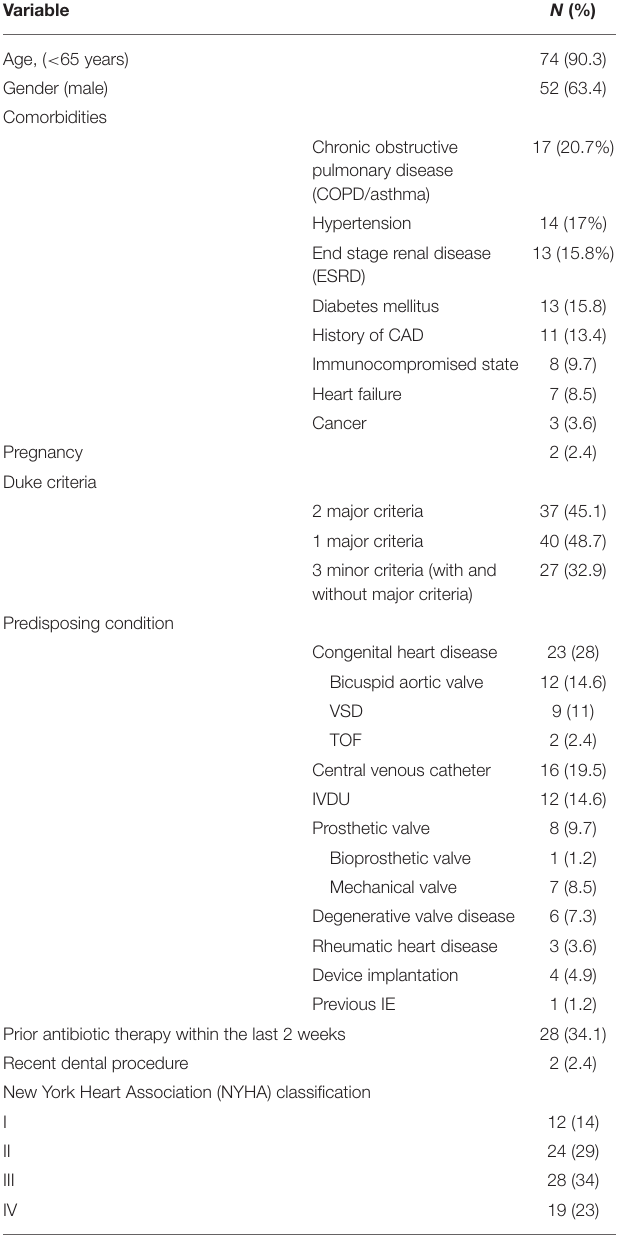
TABLE 1 | Patient characteristics and the underlying condition.